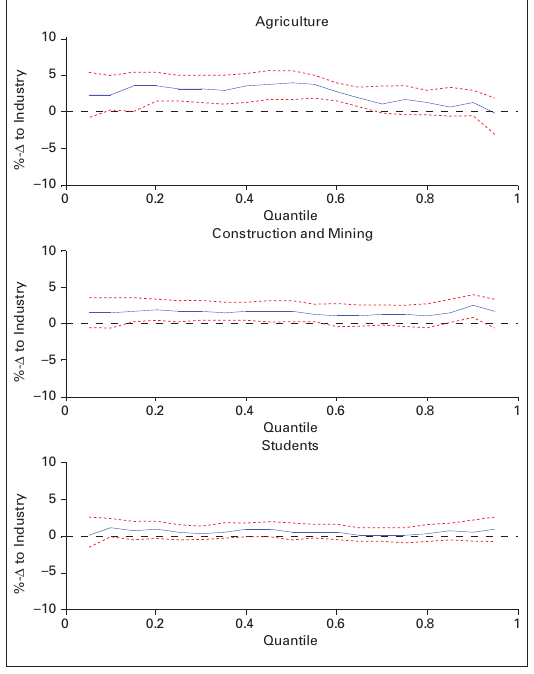
In comparison to the largest socio-economic subsample – industrial production (reference group) – employees in the agricultural and construction sectors show significantly higher values for most quantiles. Students show cholesterol values similar to the reference category.